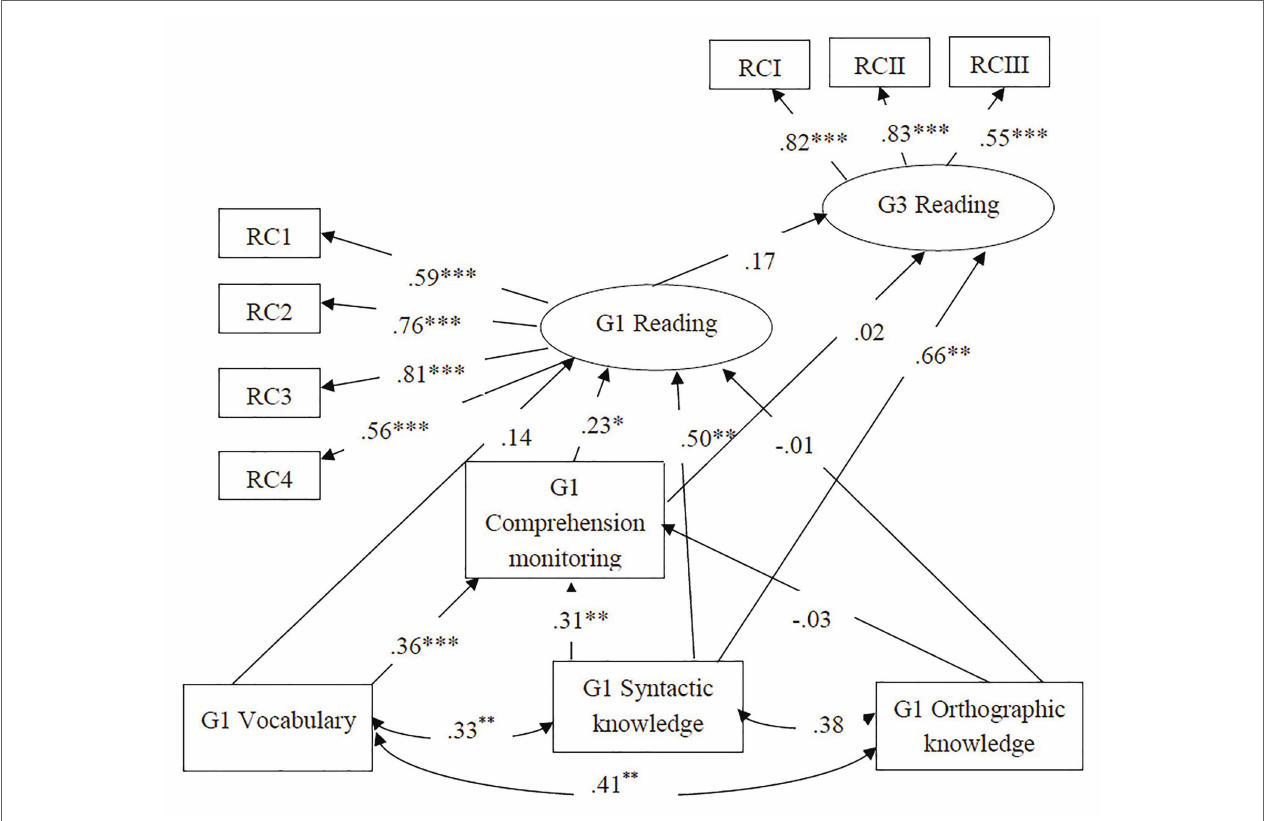
FIGURE 4 | Longitudinal relations among language skills, comprehension monitoring, and reading comprehension in Grade 3. Standardized estimates were reported. G1 = Grade 1; G3 = Grade 3; RC 1/2/3/4 = Reading comprehension task 1/2/3/4 in Grade 1; RCI/II/III = Reading comprehension task 1/2/3 in Grade 3; * p < 0.05, ** p < 0.01, and *** p < 0.001.